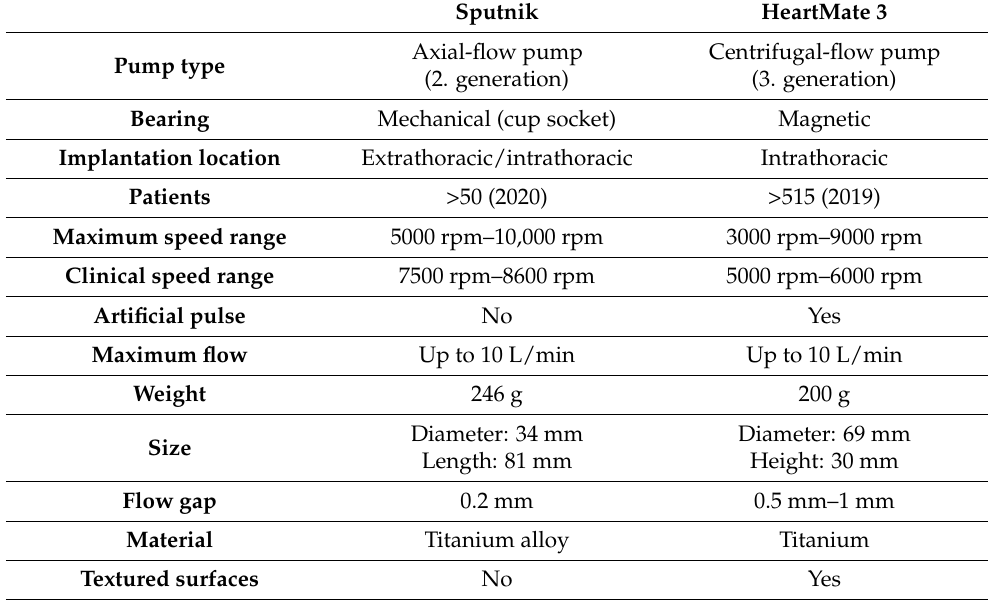
Table 1. Comparison of Sputnik and HeartMate 3 pump characteristics ([9,26,30,31,35,36]).